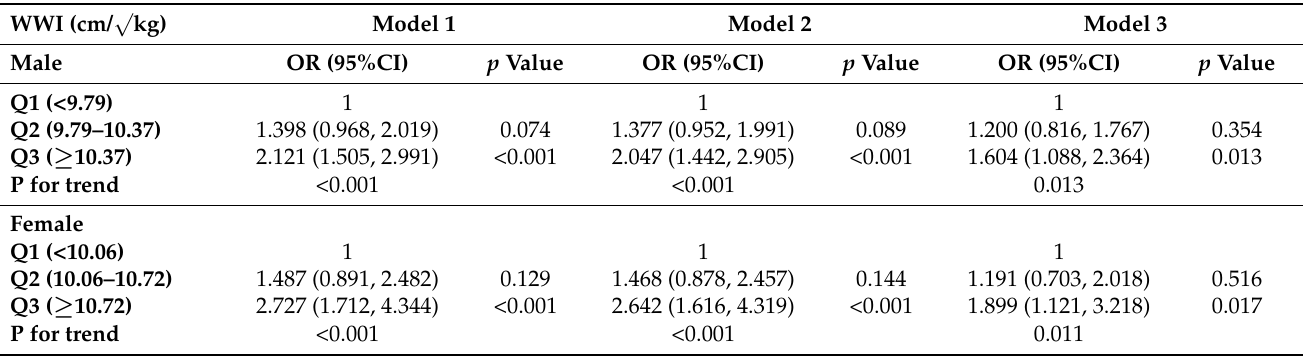
Table 3. Logistic regression analysis for the association between newly diagnosed diabetes and weight-adjusted waist